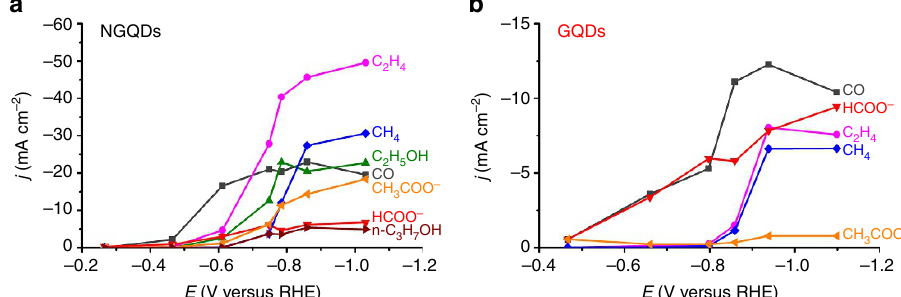
Figure 3 | Partial current densities as a function of cathode potential for various products from electrochemical CO 2 reduction. ( a ) When using NGQDs as cathode catalyst. ( b ) When using GQDs as cathode